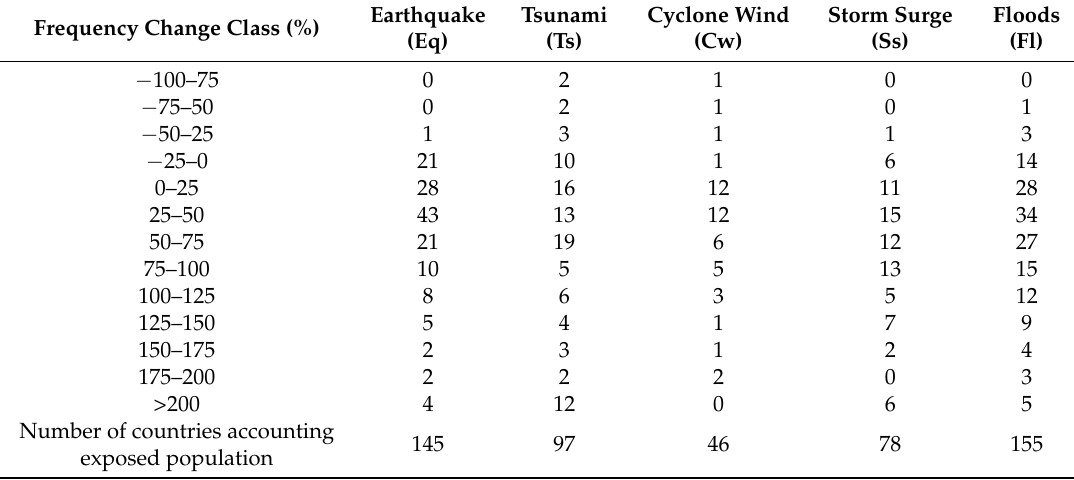
Table 3. Number of countries in the corresponding class of population change (%), in areas exposed to the selected hazards between 1990 and